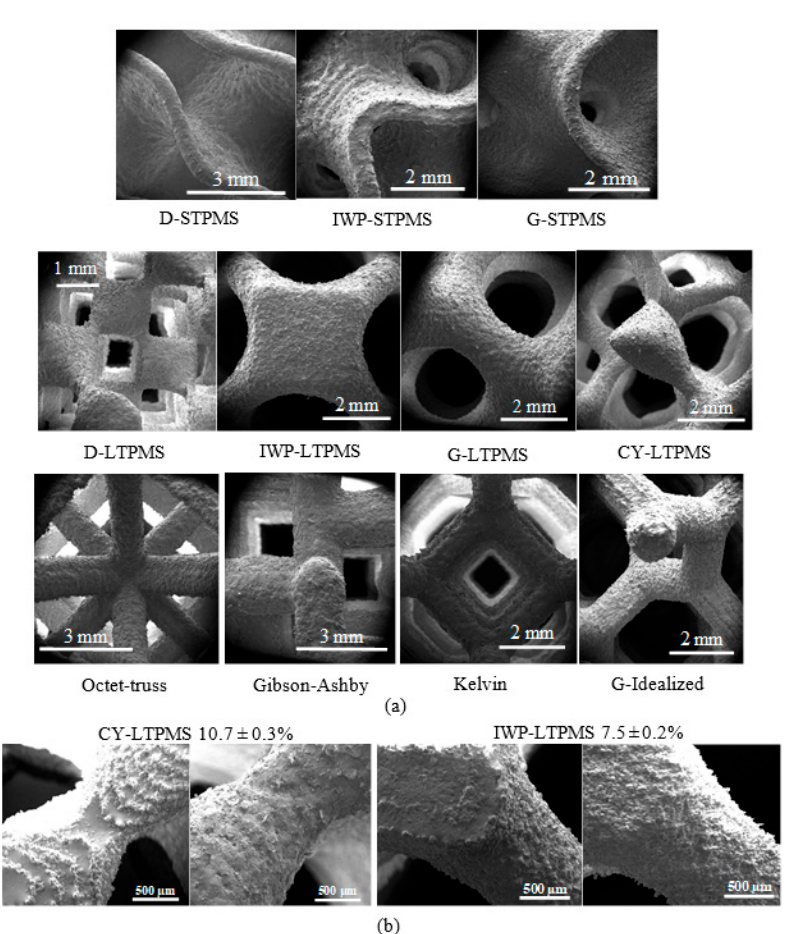
Figure 5. ( a ) Illustration of SEM images showing the printing quality of sheet-based TPMS lattices (top), ligament-based TPMS lattices (middle), and strut-based lattices (bottom). ( b ) SEM images showing the printing powder for the top (left) and bottom (right)